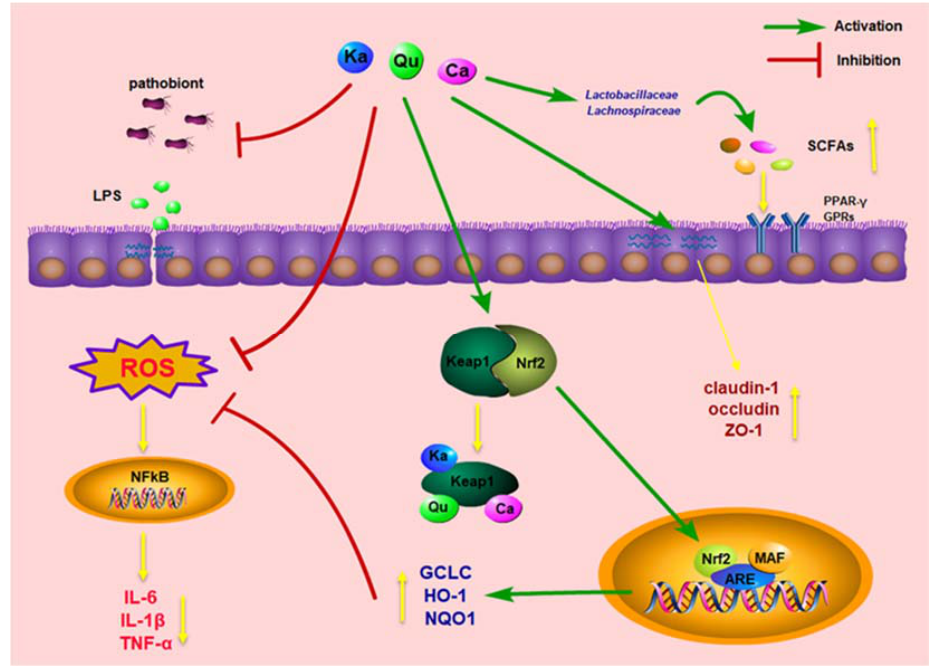
Figure 6. Proposed mechanism and pathway of GPH extracts in ameliorating DSS-induced UC in mice. Qu: quercetin; Ka: kaempferol; Ca: catechin.